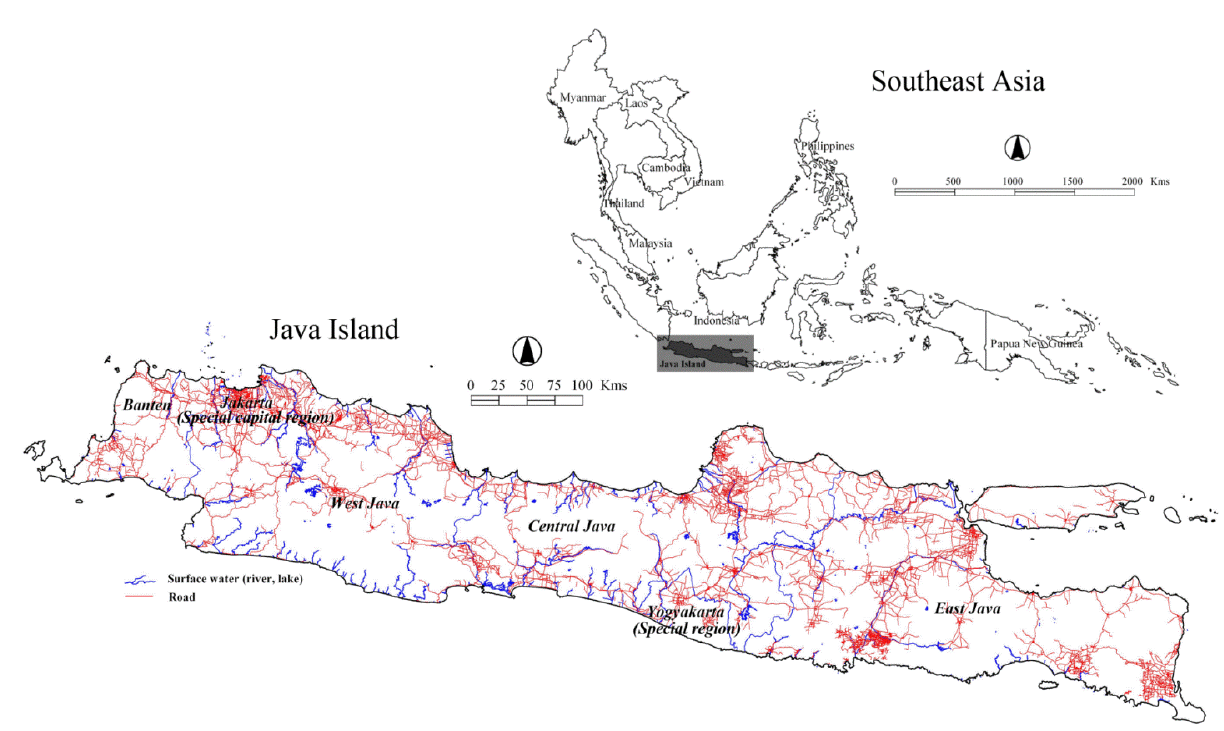
Figure 1. The study